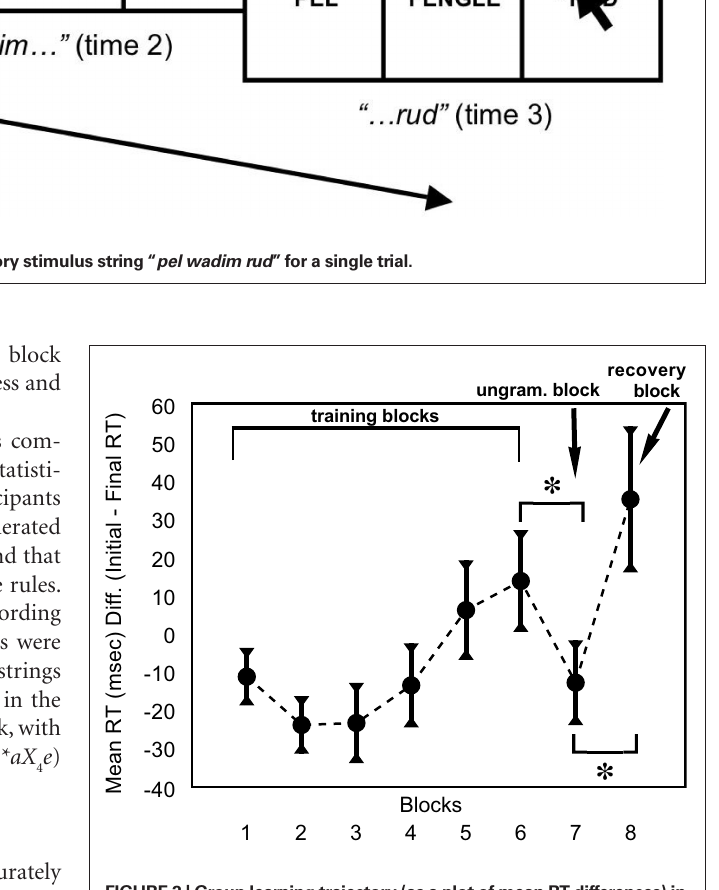
Figure 2 | group learning trajectory (as a plot of mean rT differences) in experiment